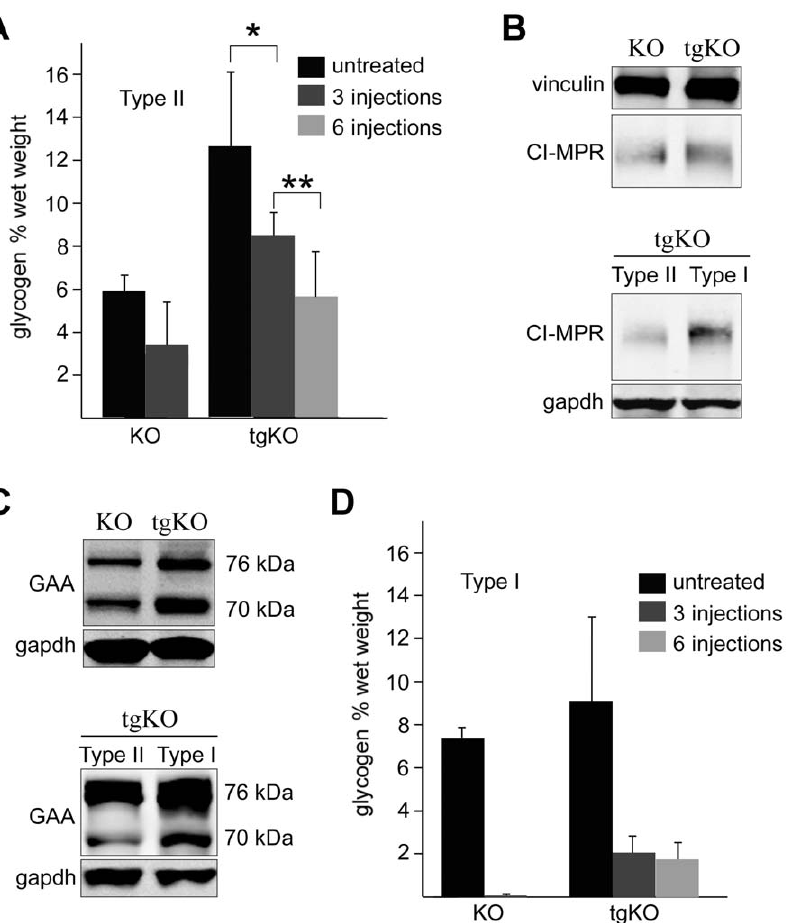
Figure 7. Effect of ERT on glycogen clearance in skeletal muscle of KO and tgKO mice. ( a ) Quantitation of glycogen levels in gastrocnemius (type II fast) muscle from KO and tgKO mice before and after ERT. Values are the mean 6 sd.; n=3 and n=13 for the untreated KO and tgKO mice respectively; n=2 and n=7 for the experiments with 3 injections for the KO and tgKO mice respectively; 6 tgKO mice were used for 6 injections of the rhGAA; * p , 0.007; ** p , 0.011. ( b and c ). Western blotting of protein lysates from gastrocnemius (fast) muscle of KO and tgKO mice and from soleus (slow) muscle of tgKO with CI-MPR and GAA antibody. The density of the CI-MPR in fast muscle of tgKO is similar to that in the KO ( Fig. 7b top ). The amount of processed rhGAA (76 and 70 kDa lysosomal forms) in fast muscle of tgKO is no less than in the KO ( Fig. 7c top; in the sample shown the amount is even more). Similar to what was previously shown for the KO [26], the receptor density and the amount of processed rhGAA in tgKO are higher in slow than in fast muscle ( Figs. 7b,c bottom ). Two KO and four tgKO mice were analyzed in each group. ( d ). Quantitation of glycogen levels in soleus muscle from KO and tgKO mice before and after ERT. Values are the mean 6 sd.; n=3 and n=6 for the untreated KO and tgKO mice respectively; n=2 and n=7 for the experiments with 3 injections for the KO and tgKO mice respectively; 6 tgKO mice were used for 6 injections of the rhGAA.